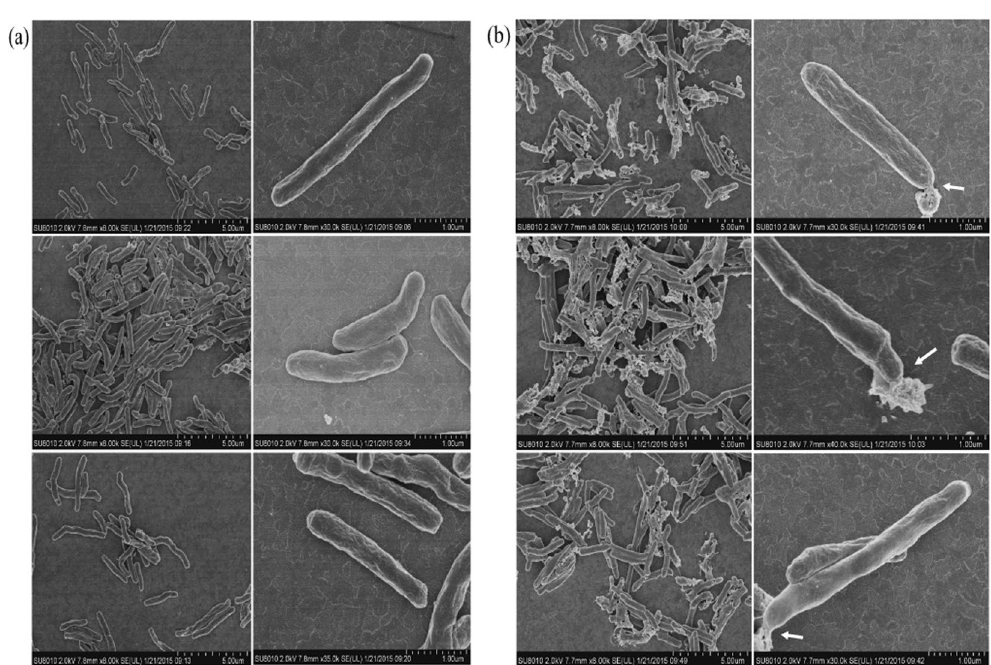
Figure 4. Scanning electron microscopy of untreated and 1 μ g/ml IMB-YH-8 treated M . tuberculosis H37Rv for 5 days. ( a ) Untreated M . tuberculosis H37Rv ( b ) 1 μ g/ml IMB-YH-8 treated M . tuberculosis H37Rv. Three independent experiments for each group are shown. Left panel, bars indicate 5 μ m; right panel, bars indicate 1.0 μ m. Arrows indicate changes in cell wall